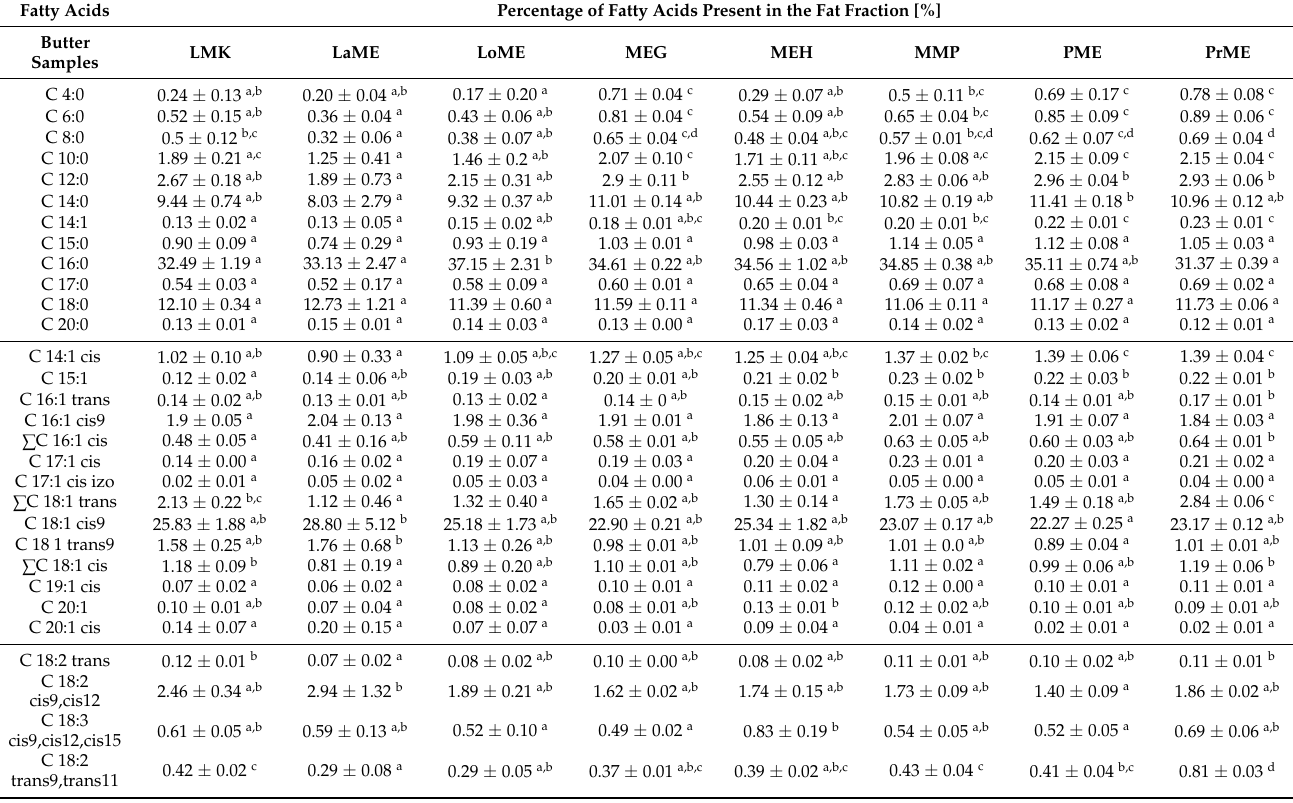
Table 8. Percentage of fatty acids present in the fat fraction of butter